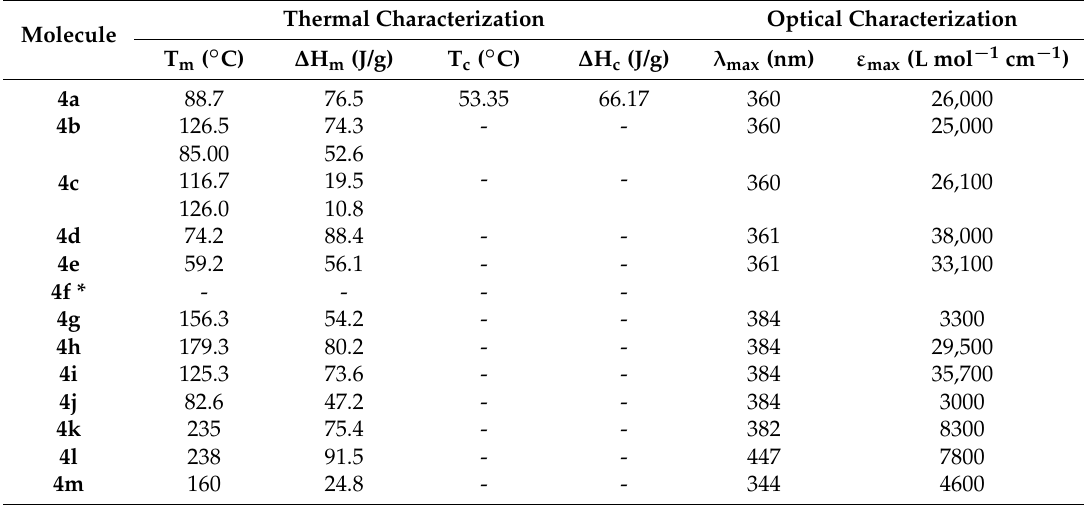
Table 1. Thermal and optical properties of compounds 4a – m . Molecule